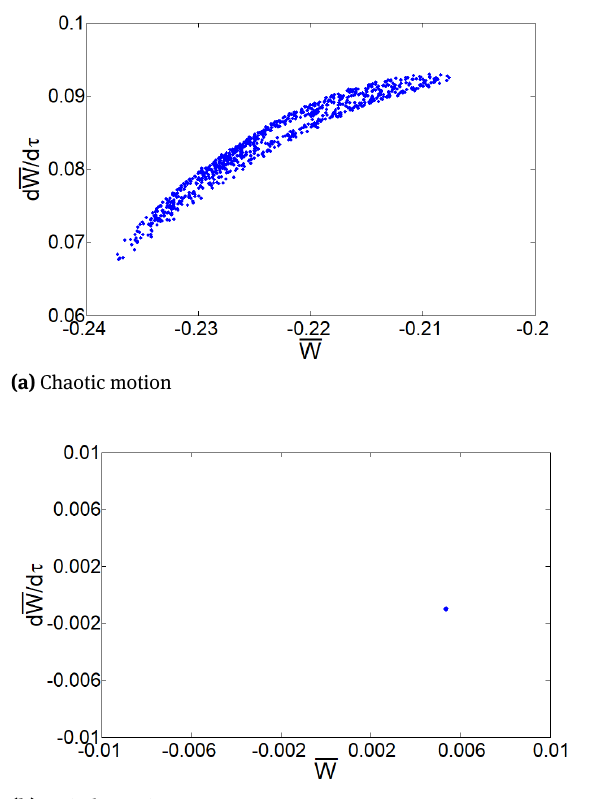
Fig. 6: Poincare maps of the micro-plate system for different mate- rial length scale parameter. (a) ¯ l = 0.01 (b) ¯ l = 0.23